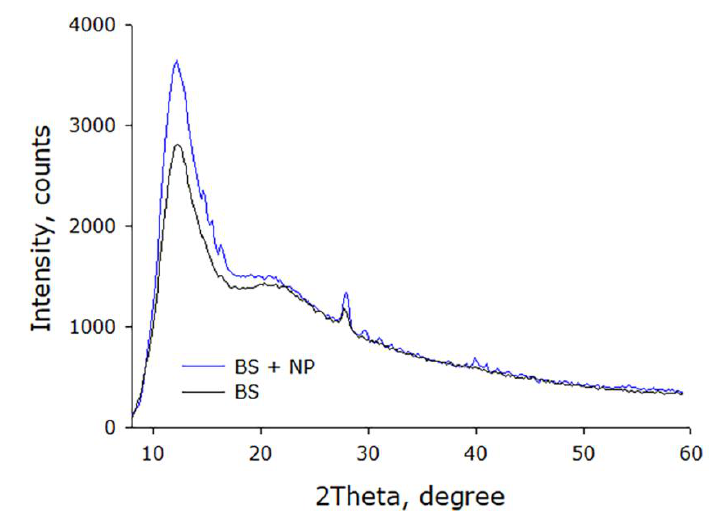
Figure 7. X-ray diffraction patterns of the resulting compositions.